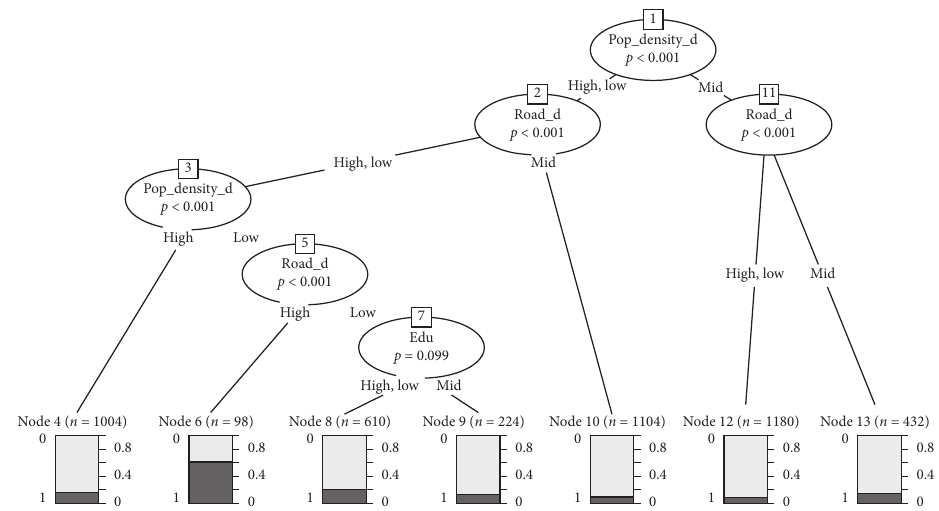
Figure 8: Conditional inference tree for all samples. Note: each node of the branch is numbered.